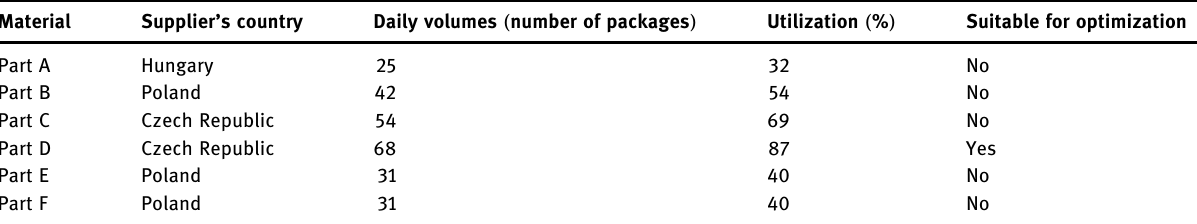
Table 1: Multiple criteria analysis of the selection of suitable material for optimization